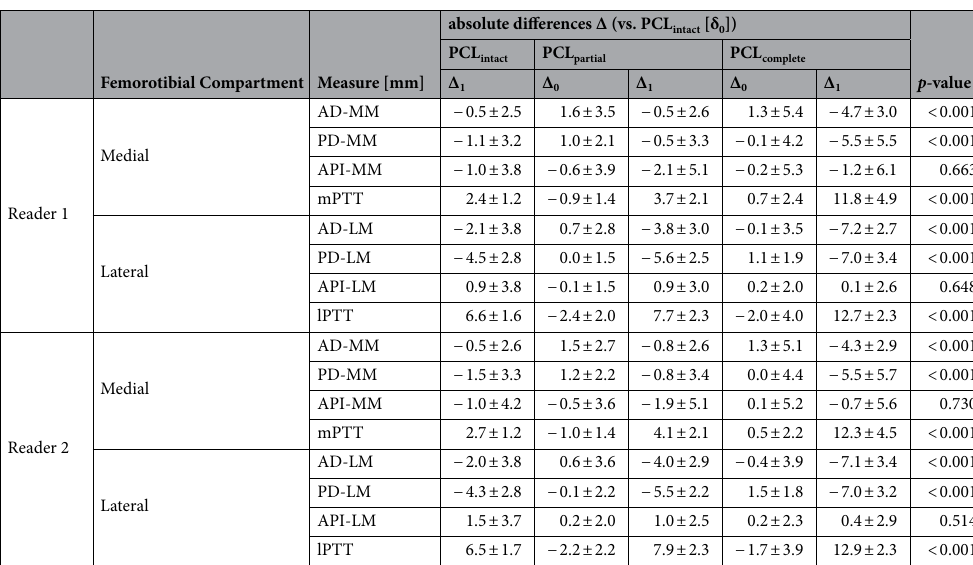
Table 2. Absolute differences of 2D manual reference measures as a function of PCL injury and loading. 2D manual reference measurements as secondary signs of PCL injury were assessed by two readers and as a function of PCL-condition PCL-condition (PCL intact —intact PCL; PCL partial —after partial PCL transection; PCL complete —after complete PCL transection) and loading configuration (unloaded [δ 0 ] and loaded [δ 1 ]). Absolute values were related to δ 0 [PCL intact ] to determine absolute changes (Δ x ) for each PCL condition (Δ x [PCL-condition] = δ x [PCL-condition] − δ 0 [PCL intact ]). Data are presented as means ± standard deviation. Statistical analysis was based on repeated measures ANOVA tests and significant findings are indicated in bold type. Sequential numbers in square brackets indicate the corresponding post-hoc details as given in Supplementary Table 2. For detailed explanations of the 2D manual reference measures, please refer to Supplementary Fig. 2. Abbreviations: PCL—posterior cruciate ligament. PTT—posterior tibial translation. lPTT (lateral PTT, i.e., PTT of the lateral femorotibial compartment). mPTT (medial PTT, i.e., PTT of the medial femorotibial compartment). AD-MM—anterior displacement of the medial meniscus. AD-LM— anterior displacement of the lateral meniscus. PD-MM—posterior displacement of the medial meniscus. PD-LM—posterior displacement of the lateral meniscus. API—anterior–posterior